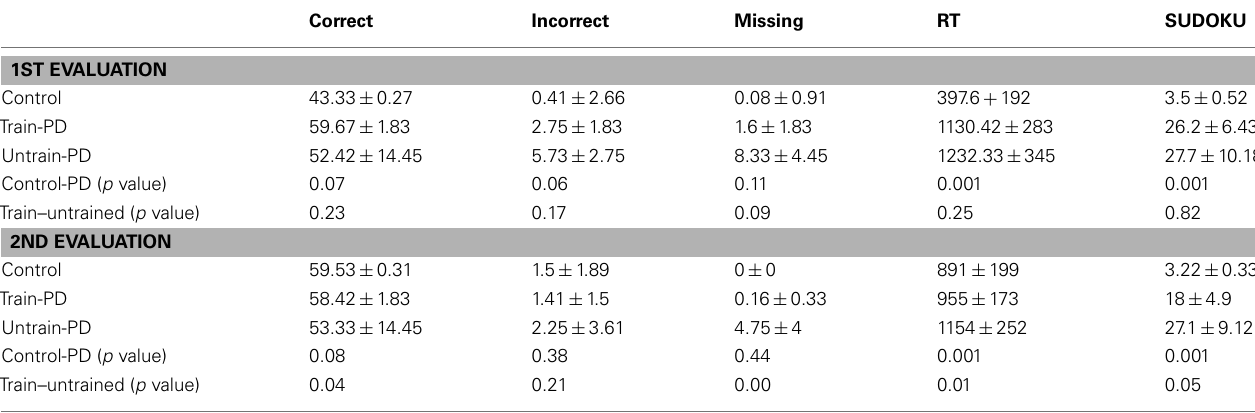
Table 2 | Mean Stroop scores (correct, incorrect, missing answers, and reaction time) in PD and controls from the first and second